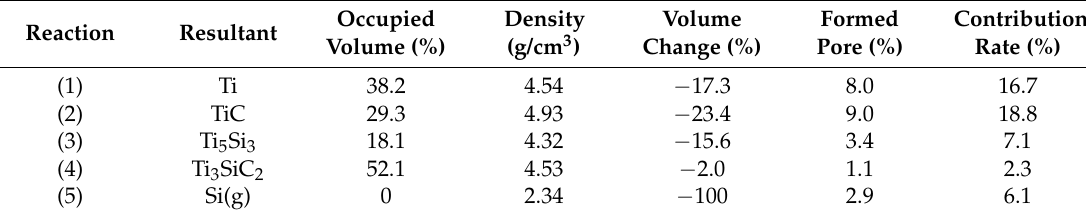
Table 2. The volume and pore changes after the